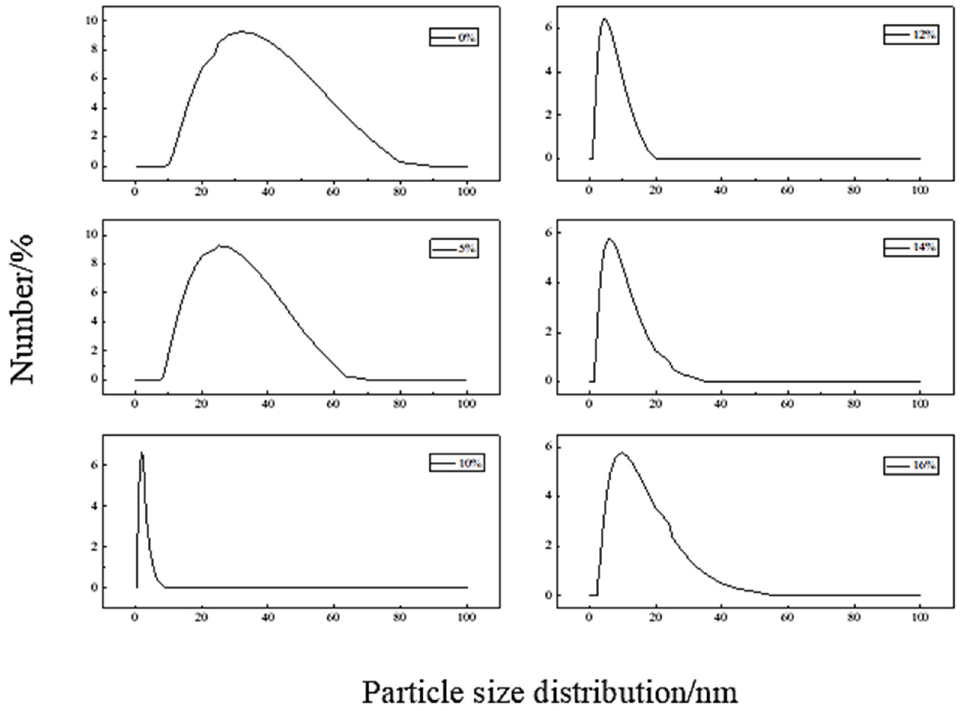
Figure 9. The effect of dispersant dosage on pendimethalin suspension particle size.